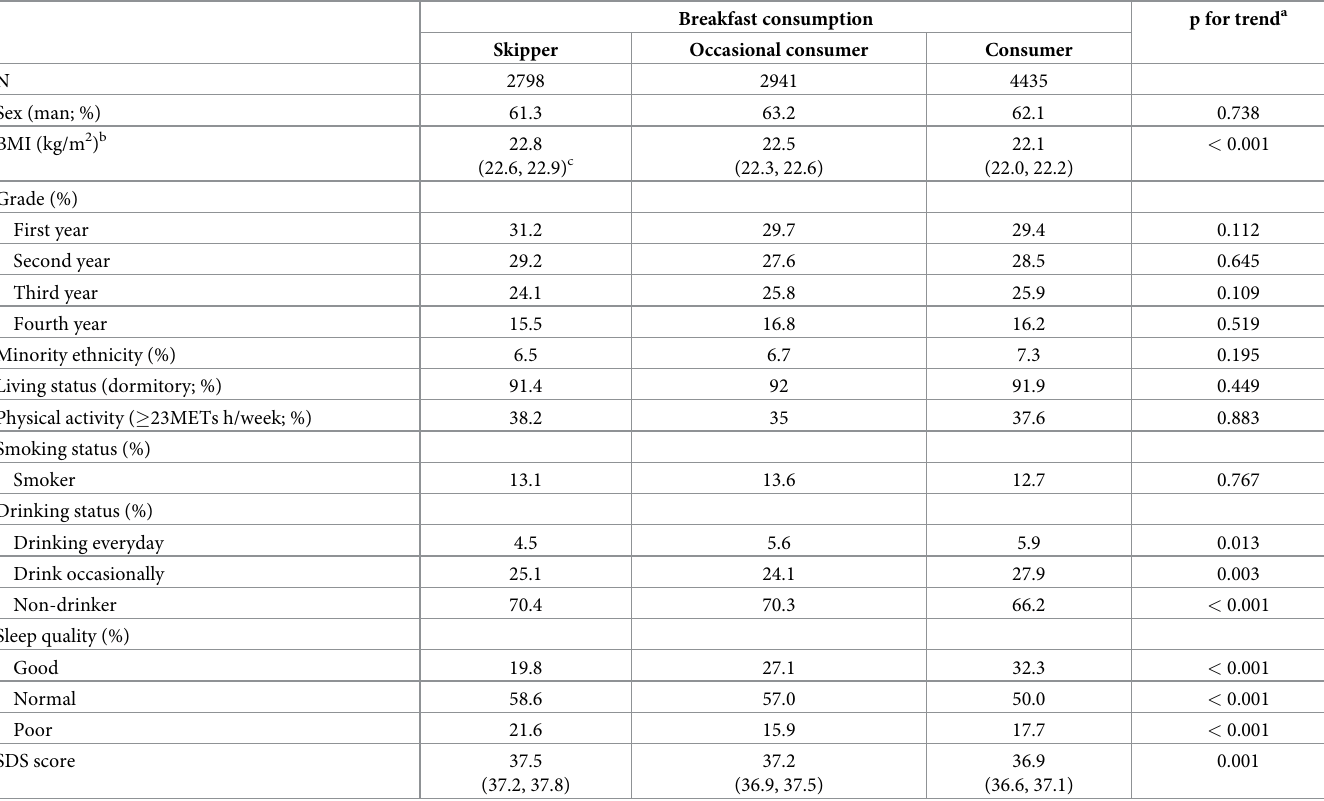
Table 1. Characteristics of participants according to breakfast consumption.